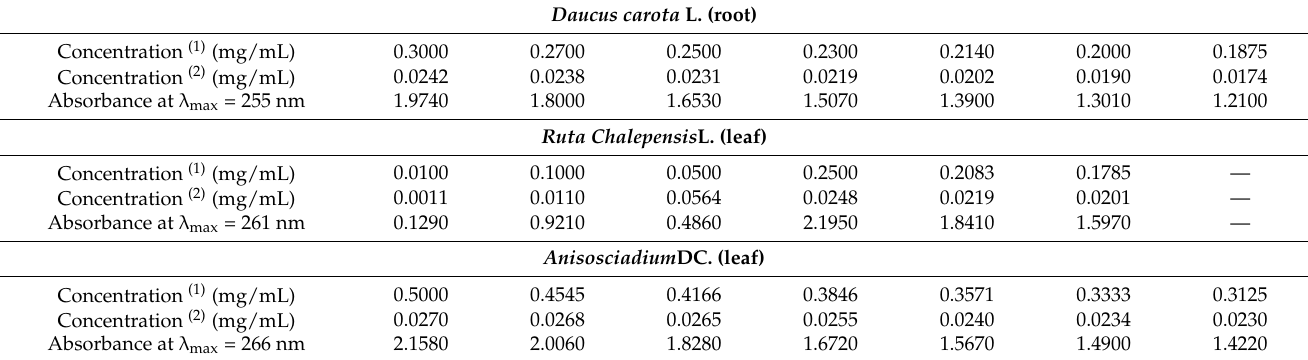
Table 2. Two comparison methods for total polyphenol content (TPC) in the indicated plant extract. Daucus carota L.